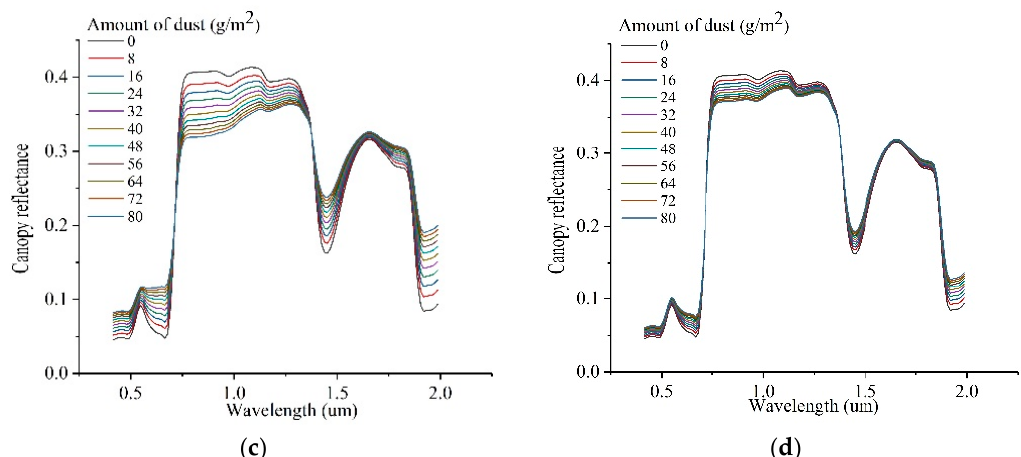
Figure 6. The simulated spectral results of maize canopy under different dust retention conditions ( a ) is dust retention on all the layers of canopy, ( b ) is dust retention only on the top layer of canopy, ( c ) is dust retention only on the middle layer of canopy, and ( d ) is dust retention only on the bottom layer of canopy).